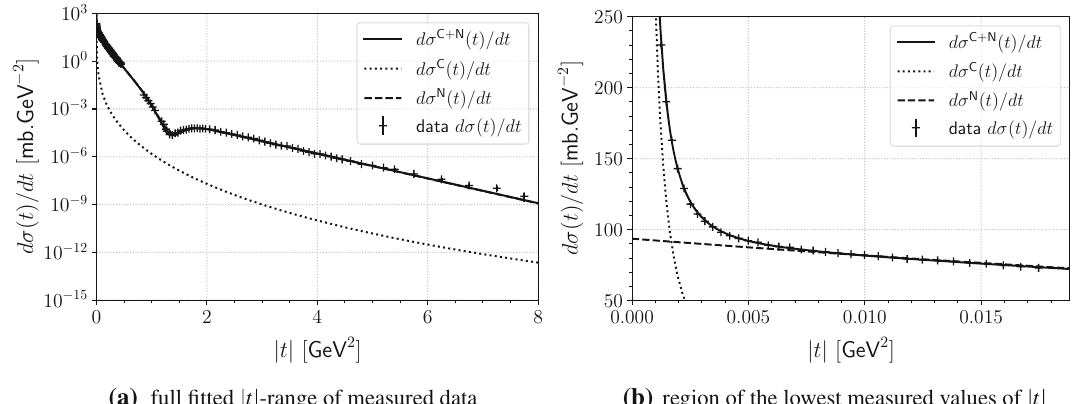
Fig. 1 Eikonal model of Coulomb-hadronic interaction fitted to measured elastic pp differential cross section at energy of 52.8 GeV in the interval | t | ∈ (cid:7) 0 . 00126 , 7 . 75 (cid:8) GeV 2 corresponding to Fit 1, i.e., central picture of elastic pp scattering. Fit 2 leading to peripheral picture of elastic scattering gives similar graphs